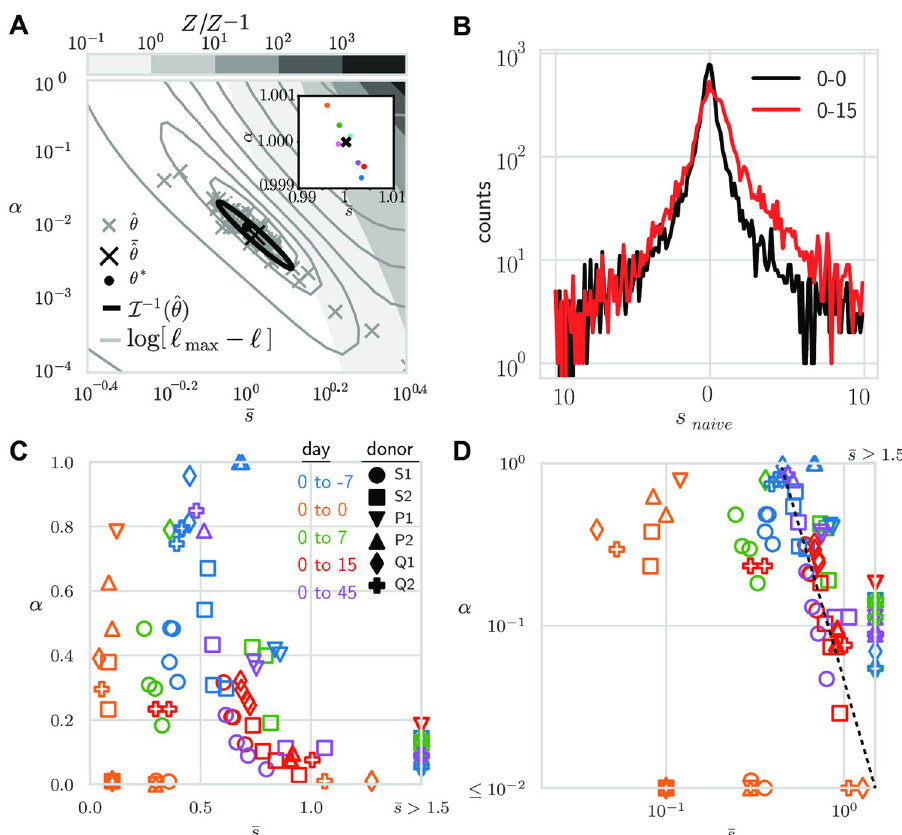
Fig 6. Inference of clonal expansion on synthetic and real data. (A) Robustness of the re-inference of the expansion parameters from synthetic data generated with value y � ¼ ð � s � ; a � Þ ¼ ð 1 : 0 ; 10 (cid:0) 2 Þ (black dot). Robustness is illustrated exp in three different ways: 1) scatter of the re-inferred ^ y (obtained by maximum likelihood) for 50 realizations (gray exp crosses, average shown by black cross); 2) isocontour lines for the log-likelihood from one realization (gray contours lines); and 3) ellipse representing the expected variance from one realization, obtained from the inverse Fisher information, I (cid:0) 1 (black line). In addition, gray scale contour regions increasing to the upper-right denote Z 0 / Z − 1, the excess in the used normalization ( ν = 2, f min satisfying N h f i = 1; for mouse-sized repertoire parameters: N = 10 6 , ρ ( f ) N reads = 10 4 . Inset shows result for human-sized repertoire ( N = 10 9 , N reads = 10 6 ). (B) Empirical histograms of naive log-frequency fold-change s naive = ln( n 0 / n ). For example data: day-0/day-0 and day-0/day-15 pair comparisons averaged over donors. (C) Application to yellow fever vaccination data. Optimal values of α and � s across all 6 donors and days relative to the day of vaccination (day 0). Each pair of different time points allows for 4 comparisons thanks to replicates. Same-day comparisons allow for 2 comparisons depending on which replicate is used as reference. (D) Same data from (C) plotted on logarithmic scales for reference. Comparisons with days other than 0 fall on straight line (guide to the eye, dashed line).